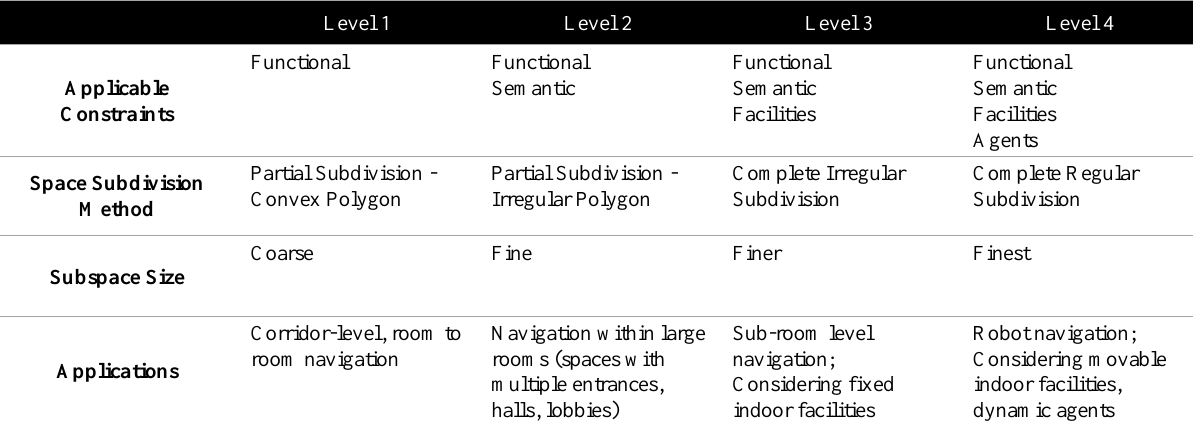
Table 1 . Specifications for applicable constraints and subspacing methods for each